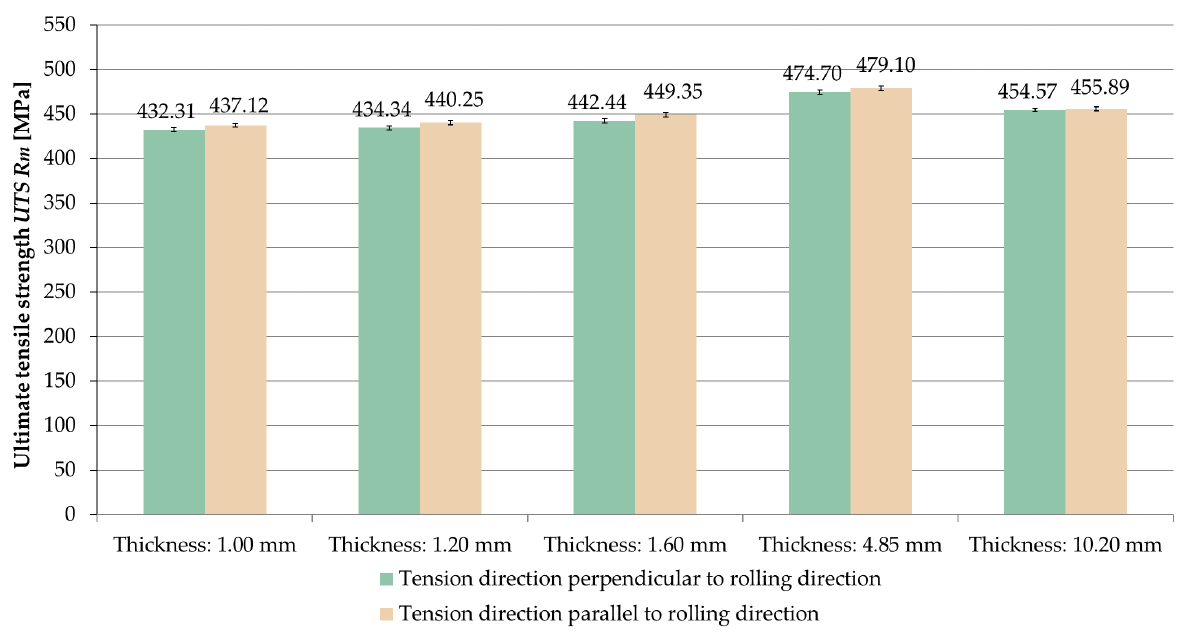
Figure 8. Ultimate tensile strength UTS R m depending on the thickness of the sample and the ratio of the tension direction to the rolling direction.